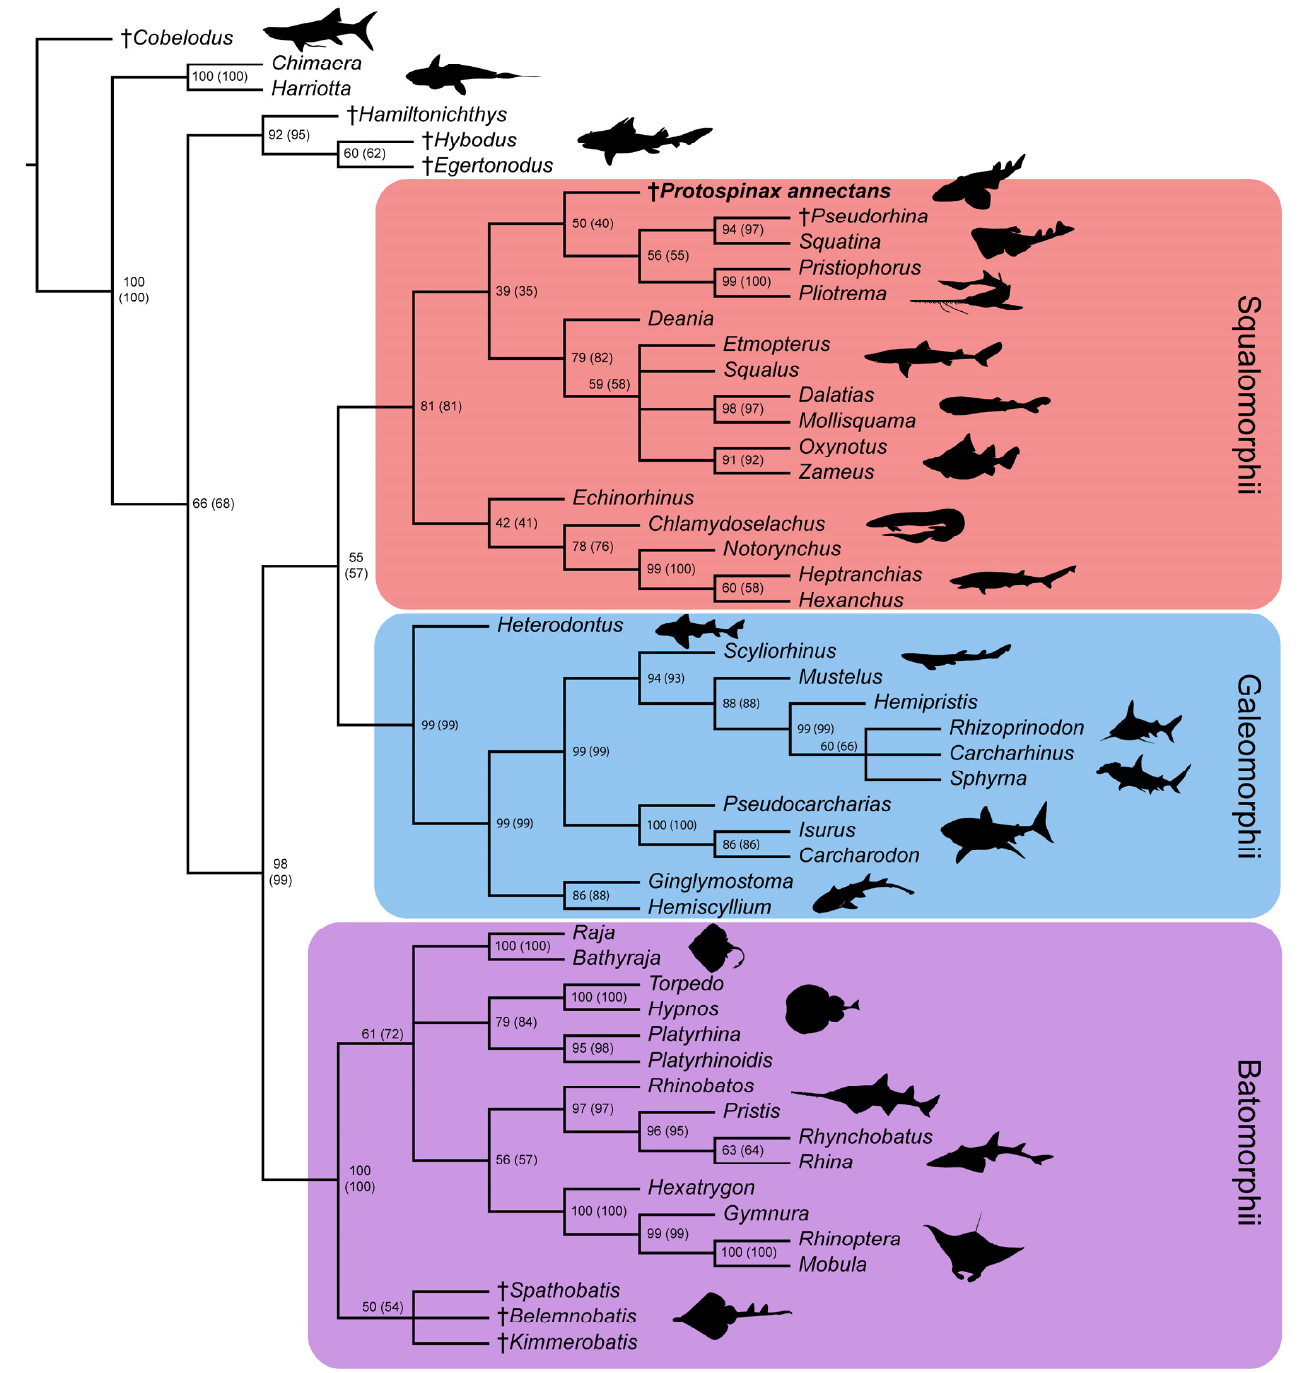
Figure 10. Majority-rule consensus tree from the morphological data under a conservative molecular backbone constraint with bootstrap- and jackknife frequencies (jackknife values are in brackets). Daggers preceding taxon names denote extinct taxa. Silhouettes were either drawn by the authors (PLJ, MAS) or downloaded from www.phylopic.org (all downloaded images were available for reuse under the Public Domain Dedication 1.0 license).